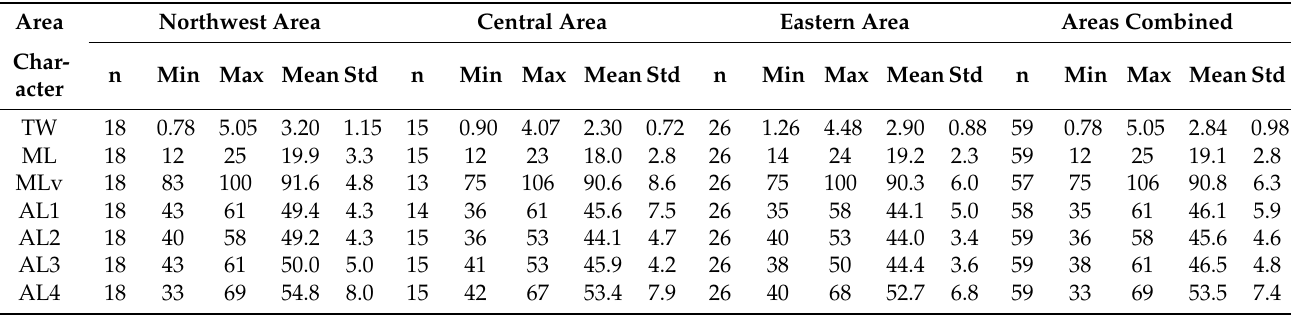
Table A3. Morphometric measurements of female Sepia typica. Sample size ( n ), minimum (Min), maximum (Max), arithmetic mean (Mean) and standard deviation of the mean (Std) are presented by region and for all regions combined for each character (See Table A1 for character abbreviations). TW (g) and ML (mm), other characters given as percentage of